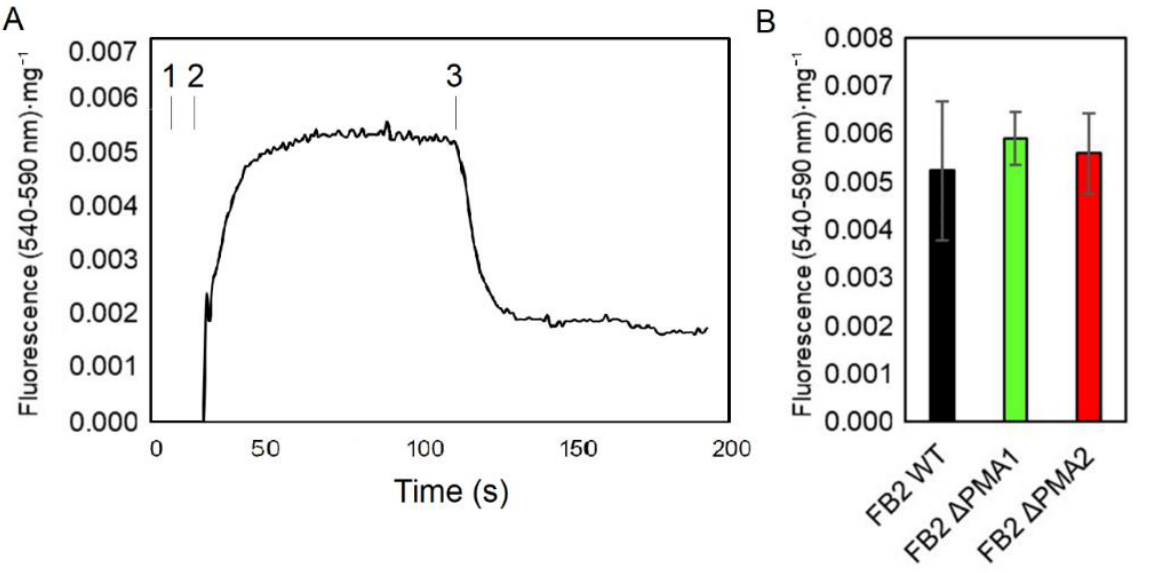
Figure 5. Measurement of membrane potential in U. maydis cells. Basidiospores were cultured in YPD for 24 h at 28 ◦ C, harvested, washed, and used to determine the changes in fluorescence of DiSC3(3) against time ( A ). The maximum value of fluorescence was obtained for each strain ( B ). Addition of 1. 0.025 mM DiSC3(3), 2. cells, and 3. 10 µ M CCCP at the indicated times. ANOVA analysis